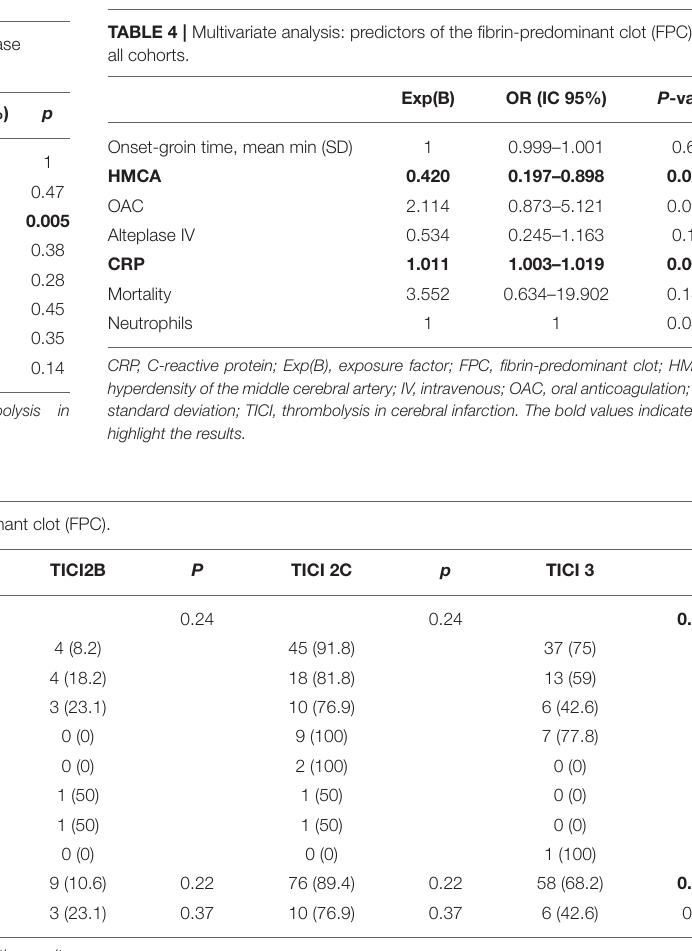
TICI, thrombolysis in cerebral infarction. The bold values indicated to highlight the